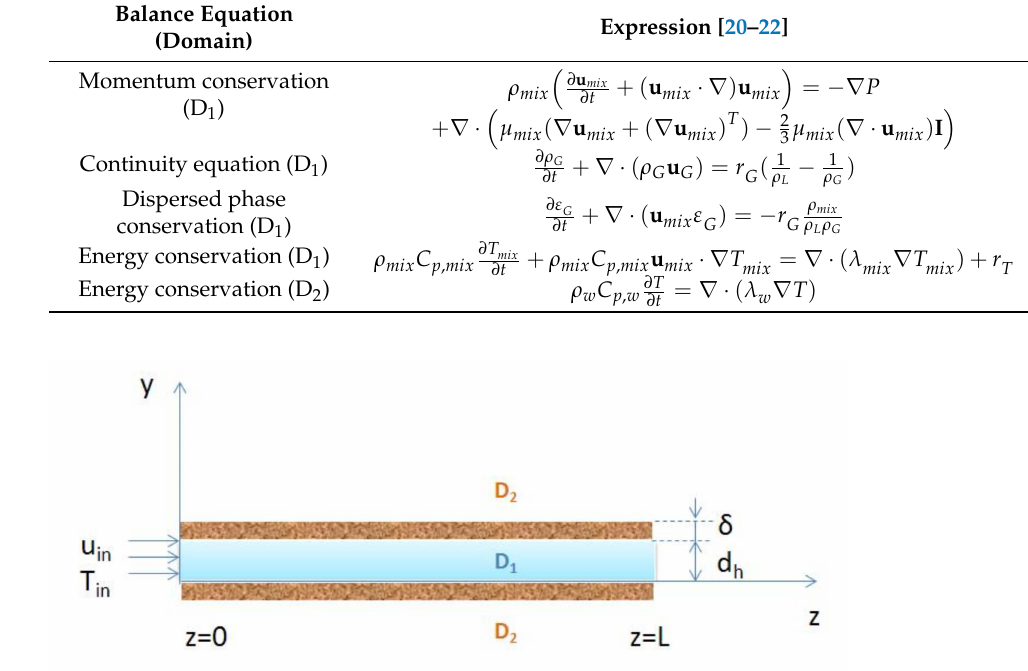
Table 1. Balance equations for homogeneous mixture flow in microchannel.